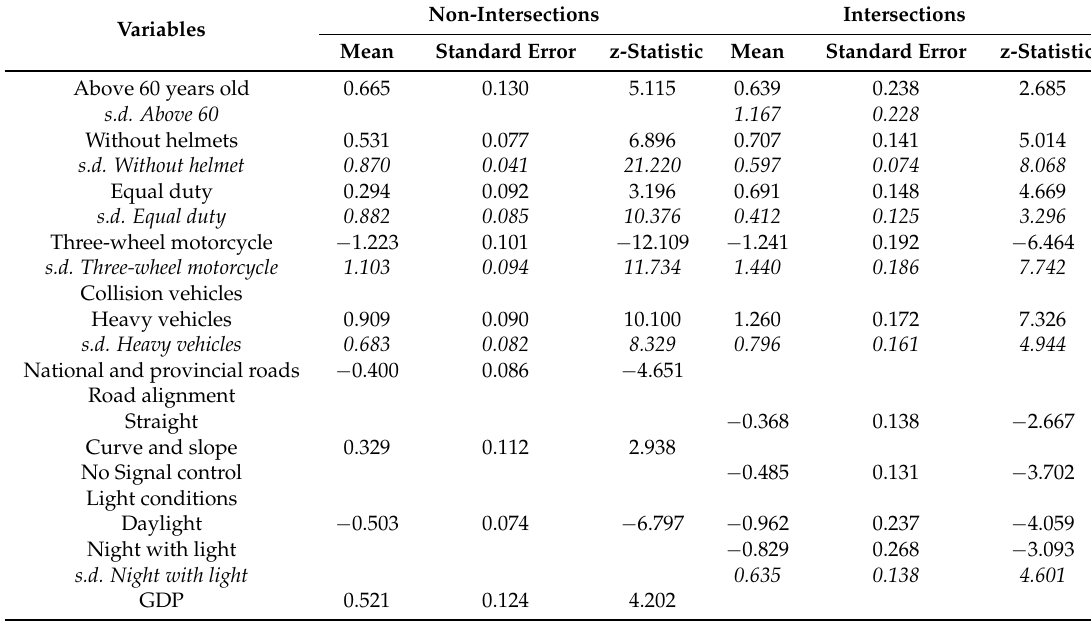
Table 3. Estimate results for mixed ordered logit